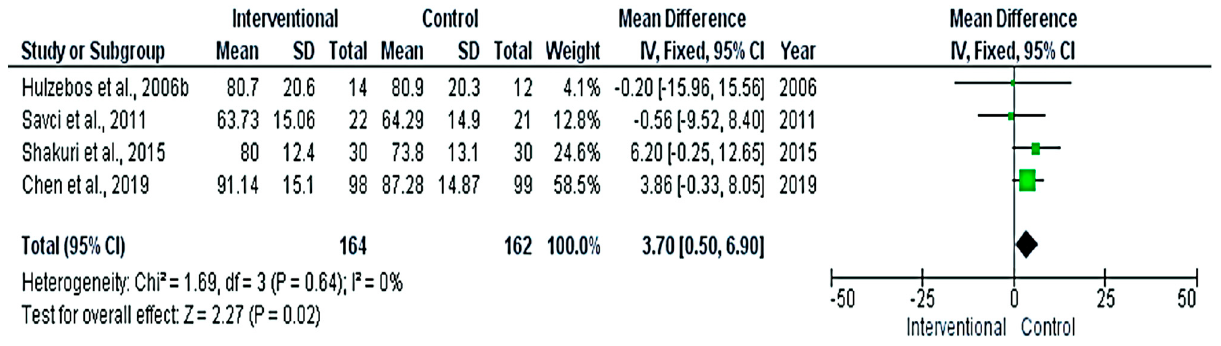
Figure 6. Forest plot evaluating FEV1% predicted in the included studies.